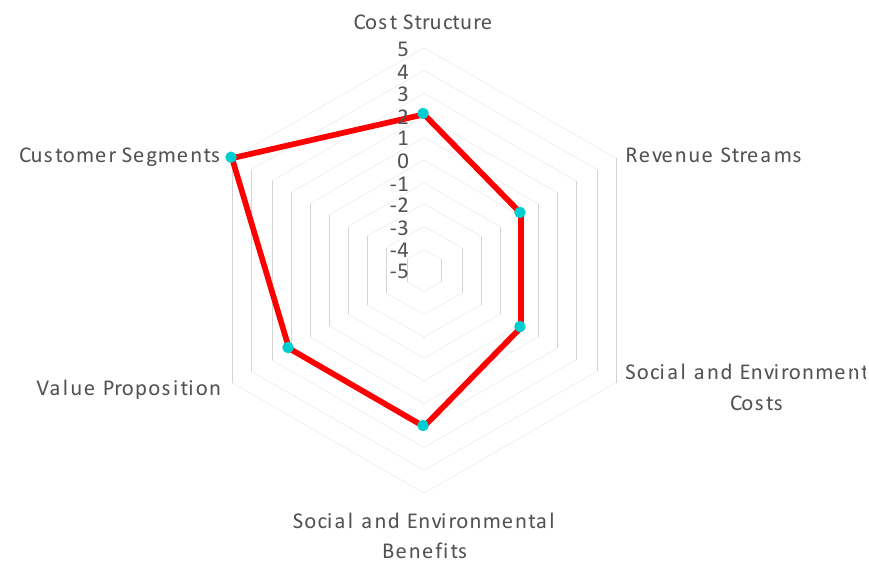
Figure 3. Radar chart of the Business Model Evaluation Tool of Santander’s street lighting system.